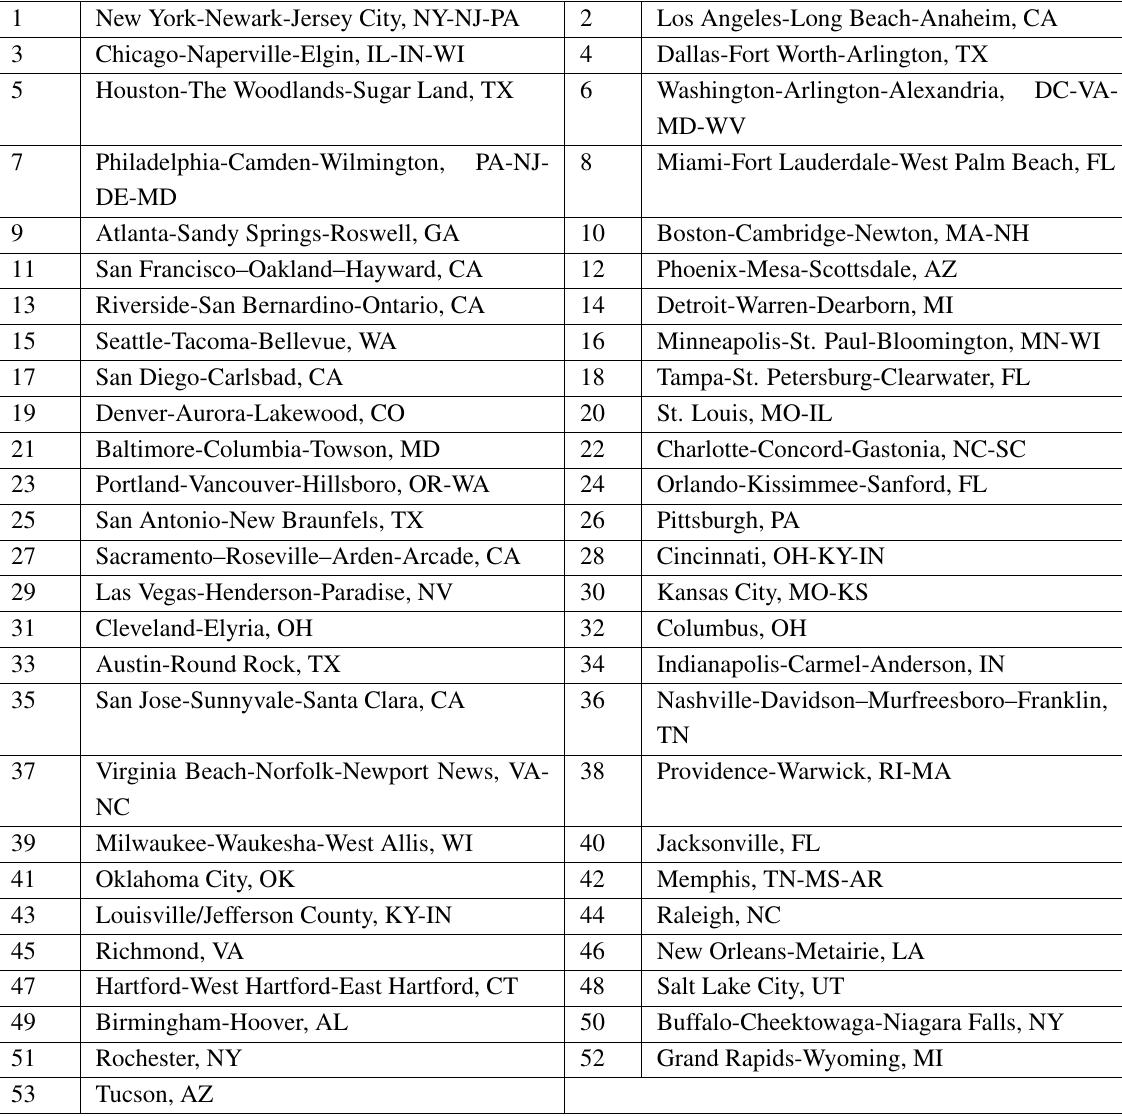
Table 1. US metropolitan areas studied in the SustaIn-LED listed by population